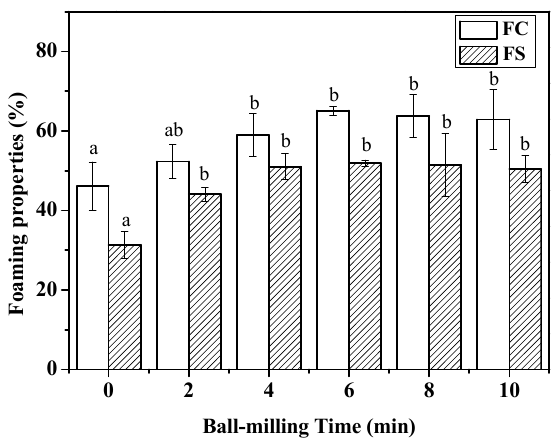
Figure 4. Effects of ball-milling time (0, 2, 4, 6, 8, and 10 min) on foaming capacity (FC) and foaming stability (FS) of CFP. Different lowercase letters denote significantly different ( p < 0.05) from each other. Error bars show the variations of three determinations in terms of standard error of mean.